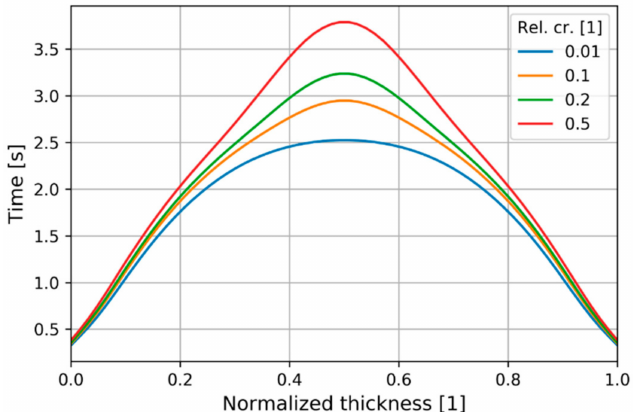
Figure 12. Time to reach different levels of relative crystallinity along the normalized thickness at